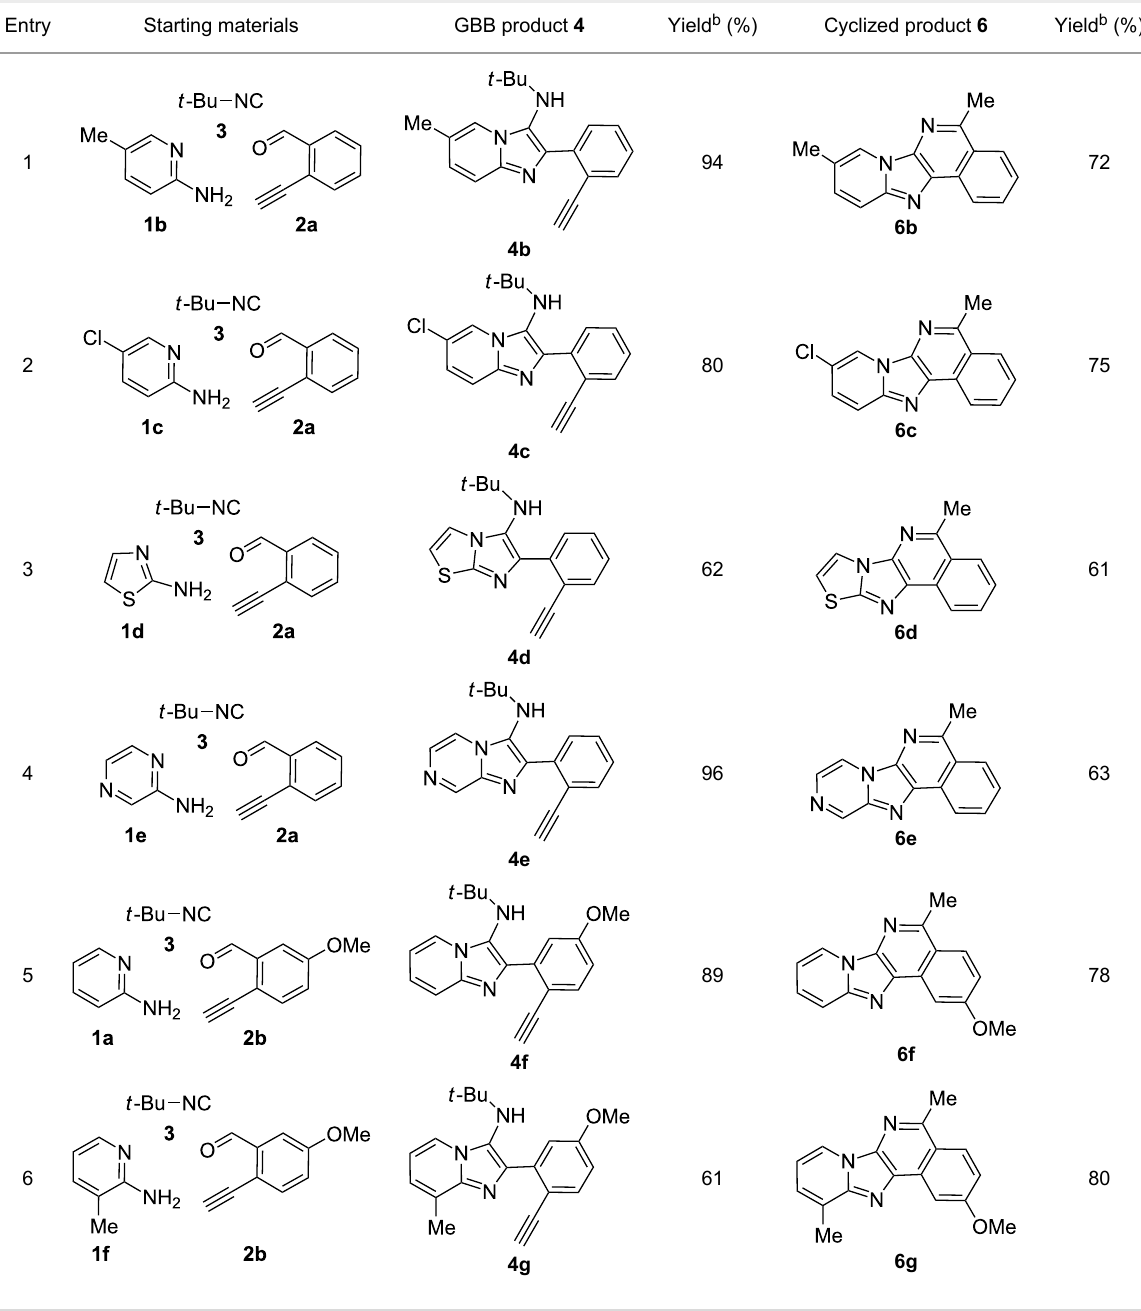
Table 2: Substrate scope for the syntheses of compounds 4 and 6 .